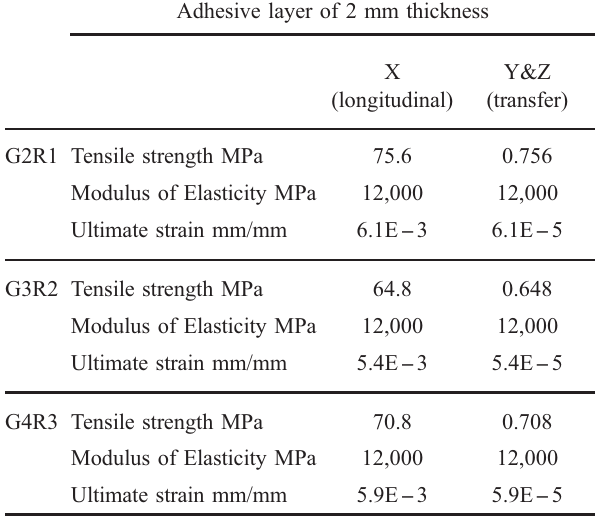
Table 3. Adhesive interface properties Adhesive layer of 2 mm thickness